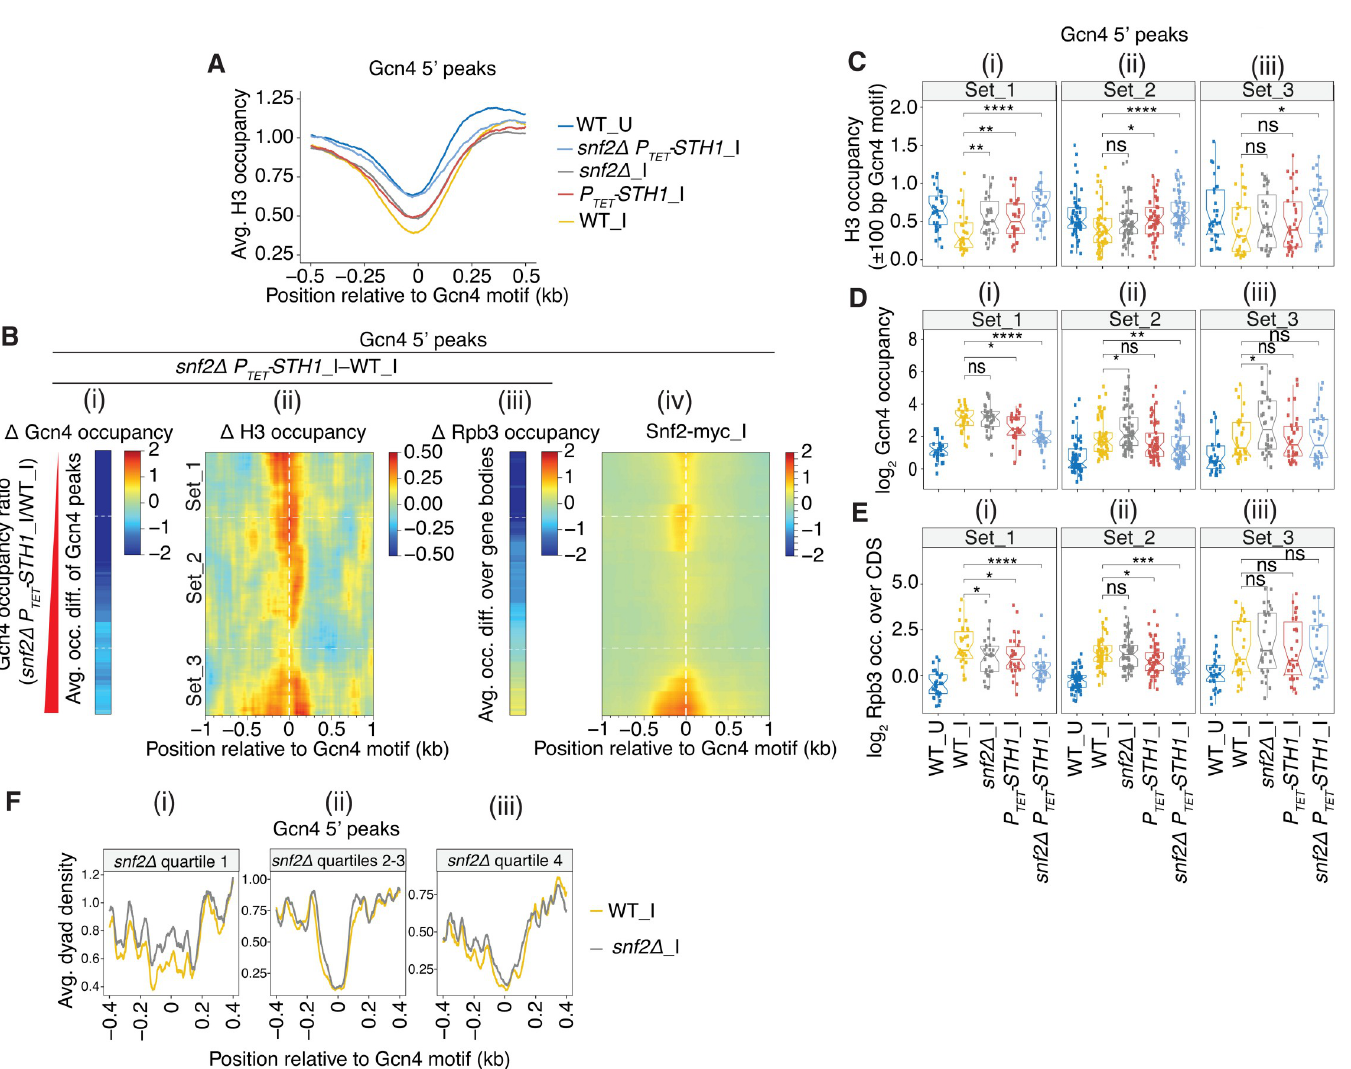
Fig 4. Defective eviction of nucleosomes surrounding 5’ Gcn4 motifs in SWI/SNF and RSC mutants. (A) Plots of H3 occupancies at each base pair surrounding the Gcn4 motifs averaged over all 5’ sites for the indicated strains/conditions, calculated from H3 ChIP-seq data. All of the average plots were found to converge at a position ~1.0 kb upstream and downstream of the Gcn4 motifs. (B) (i)-(iii) Heat maps depicting differences between snf2 Δ P TET -STH1 _I and WT_I cells for (i) Gcn4 occupancies measured as in Fig 2A(i), (ii) H3 occupancies surrounding the Gcn4 motifs of 5’ sites from H3 ChIP-seq data, (iii) Rpb3 occupancies averaged over the CDS of 5’ genes, for Gcn4 5’ sites sorted by increasing order of fold-changes in Gcn4 occupancies in snf2 Δ P TET -STH1_ I vs. WT_I cells, as in Fig 2A and 2B. (iv) heat map of corrected Snf2-myc_I occupancies surrounding the Gcn4 motifs for the same order of 5’ sites as in (i)-(iii). (C-E) Notched box plots for the 3 sets of 5’ sites defined in Fig 2A and 2B and indicated again in (B), depicting (C) H3 occupancies per base pair in the ± 100 bp windows surrounding the Gcn4 motifs, (D) log 2 Gcn4 occupancies taken from Fig 2C, and (E) log 2 Rpb3 occupancies averaged over the CDS of genes with 5’ sites. H3 and Rpb3 occupancies were calculated from ChIP-seq data of sonicated chromatin from at least 3 biological replicates of WT_U, WT_I, or snf2 Δ _I, P I and snf2 Δ P I cells. (F) Average dyad densities calculated from H3 MNase-ChIP- TET -STH1_ TET -STH1_ seq data aligned to the Gcn4 consensus motifs, as described in Fig 1E, for the quartiles of 5’ peaks defined in Fig 3D(i)-(ii) showing the smallest increases (and frequently decreases) in Gcn4 binding (i), intermediate increases (ii), or the largest increases in Gcn4 binding in snf2 Δ _I vs. WT cells